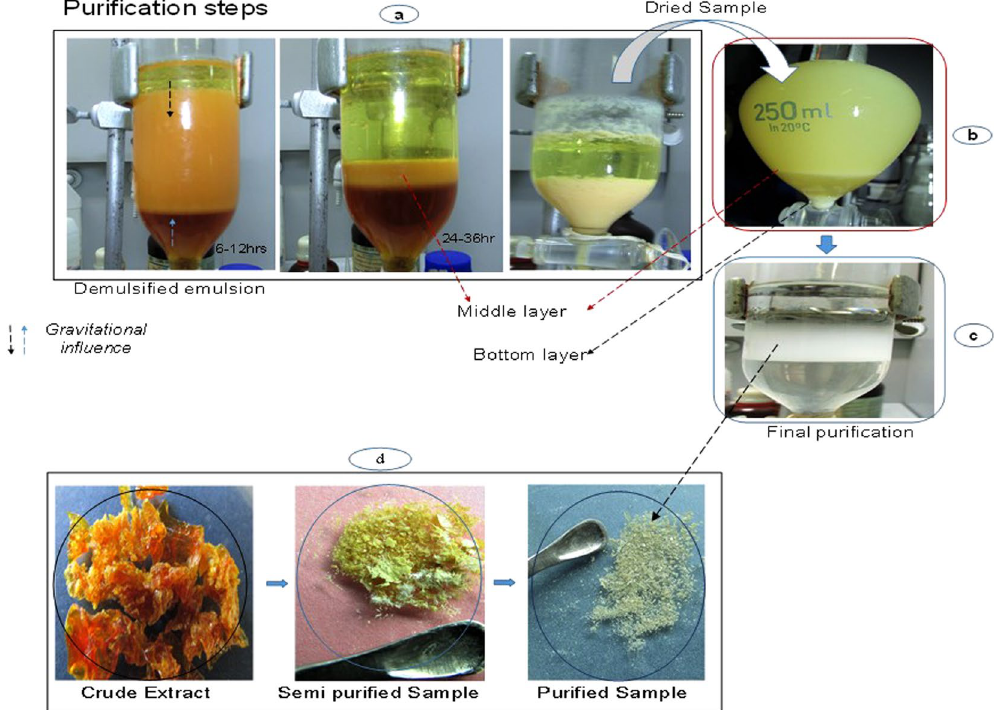
Figure 1. Production and purification steps: ( a ). The primary recovery of 4 A; ( b ) Intermediate purification step (cycle 1) showing gradual sedimentation at both middle and bottom; ( c ) Final purification step (cycle 3); ( d ) the dried extract, semi-purified and purified saponin